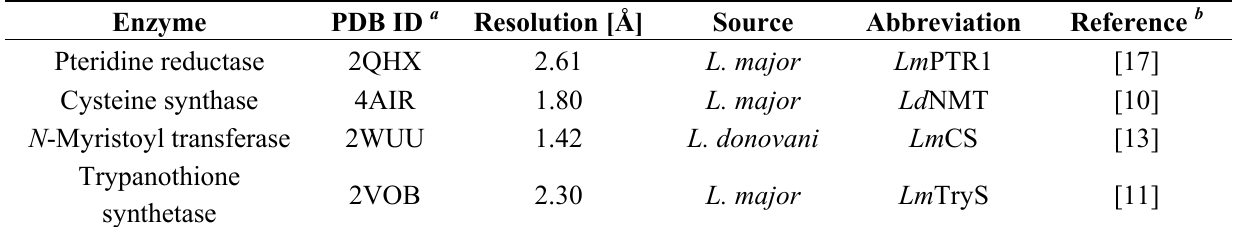
Table 1. Data of the test enzymes.